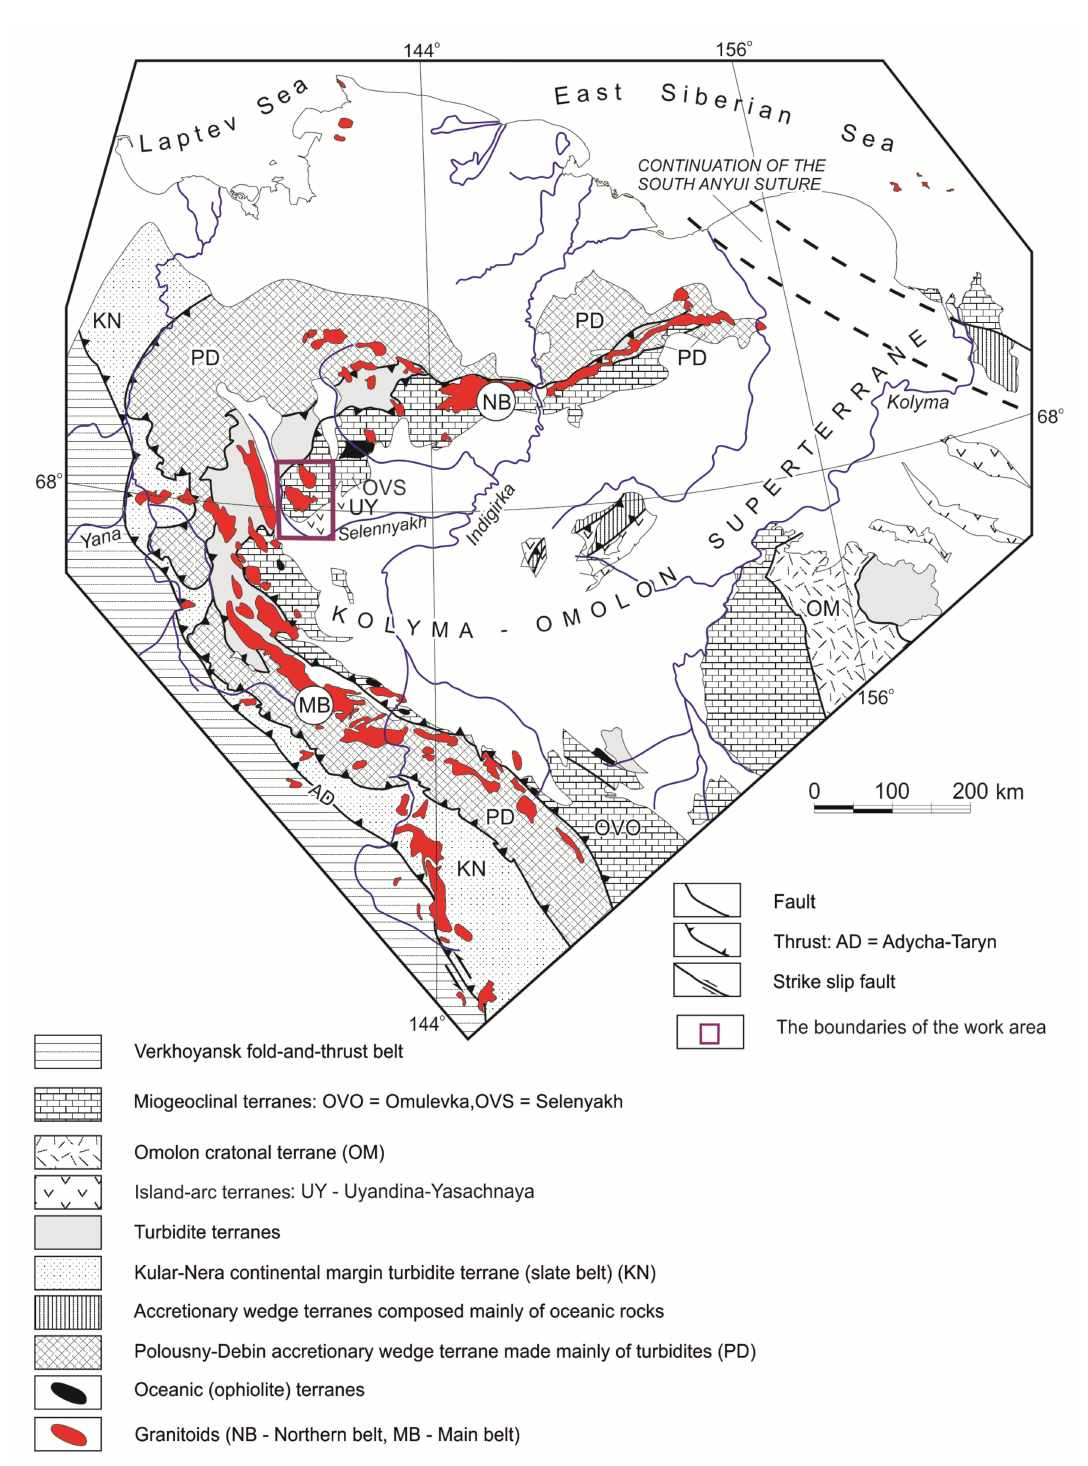
Figure 1. Tectonic map of the northeastern Verkhoyansk–Kolyma orogenic belt [1]. Despite the long-term study of the granitoid magmatism of the orogenic region, many questions of the genesis of granitoids remain controversial. This primarily concerns the role of deep sources in magmogeneration processes and the causes of the